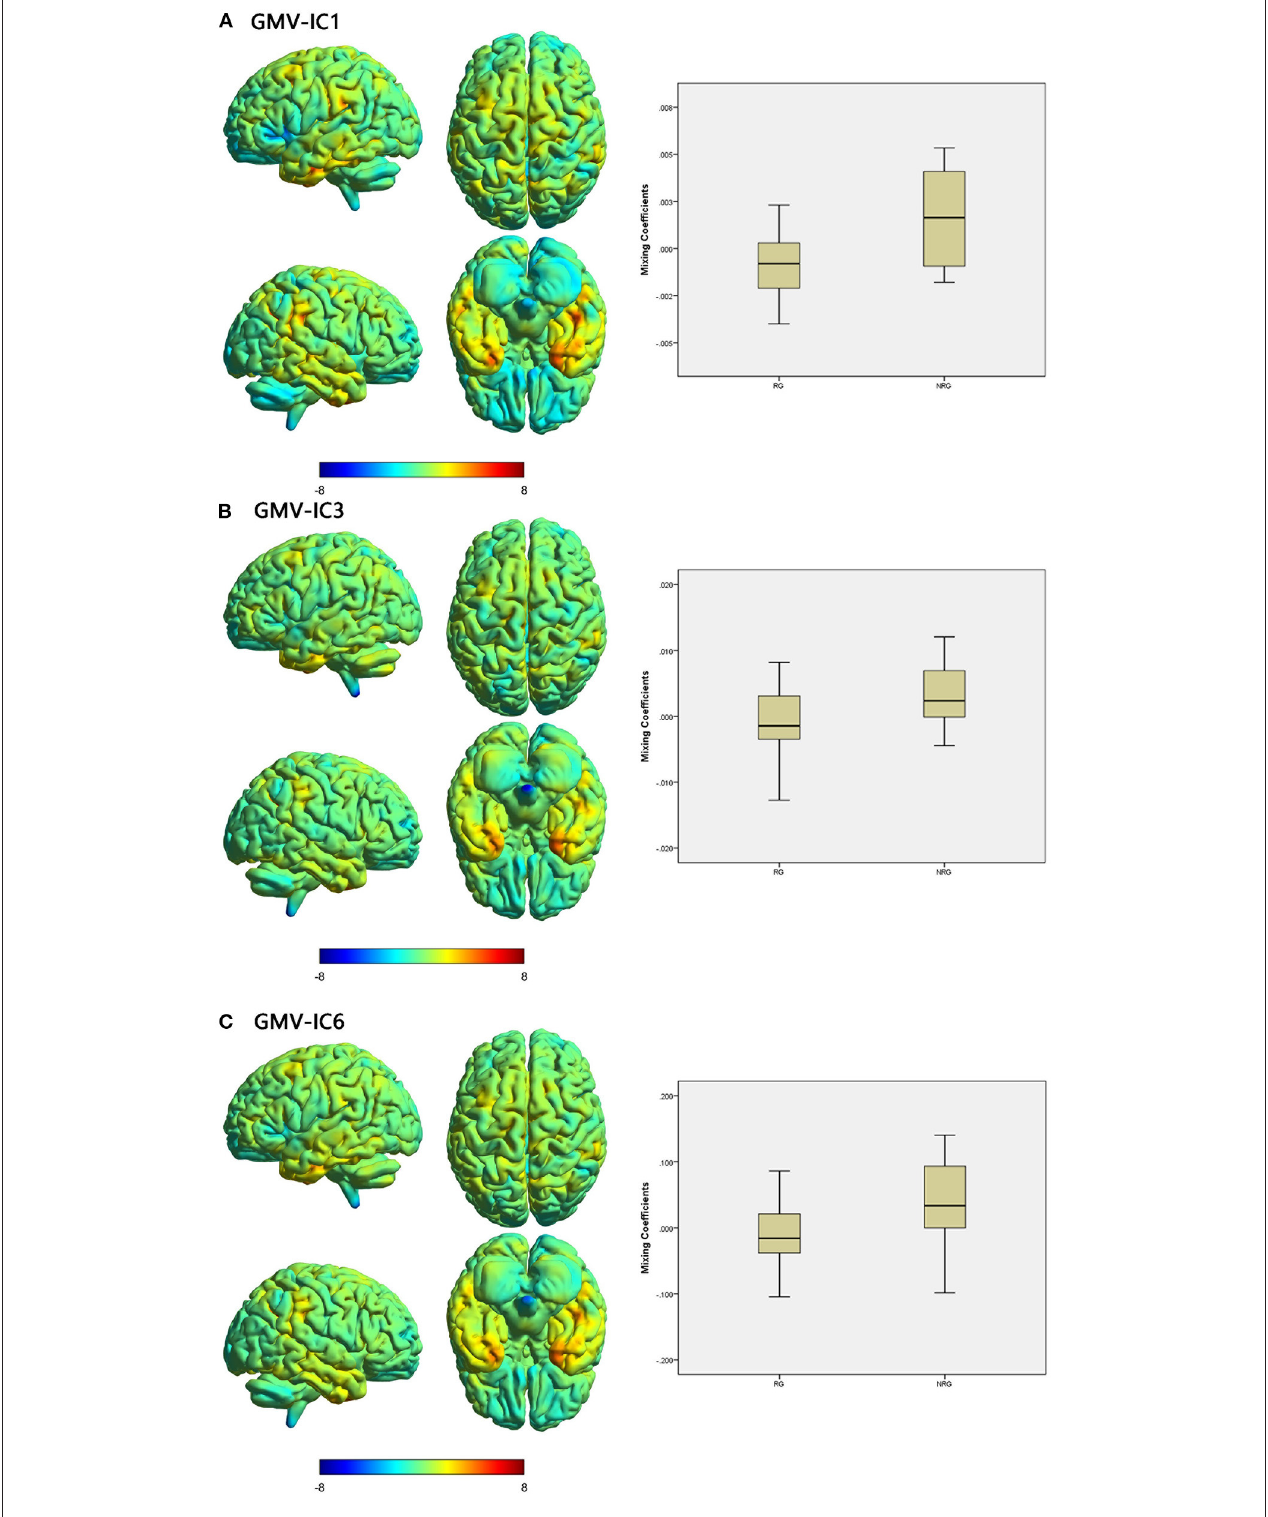
FIGURE 3 | Brain maps of specific discriminative IC and box plots of mixing coefficients between the RG and NRG. The left part of the figure is the brain